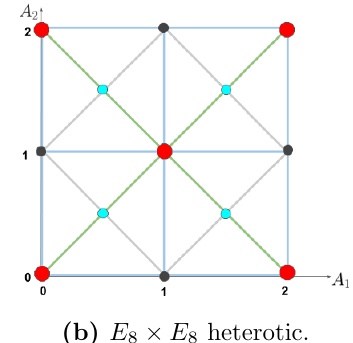
(a) SO(32) heterotic. Figure 2. Enhancement groups on the left sector of the heterotic theory on the slice of moduli space de(cid:12)ned by A 3 ;:::; 16 = 0, R = 1. See table 3 for details.